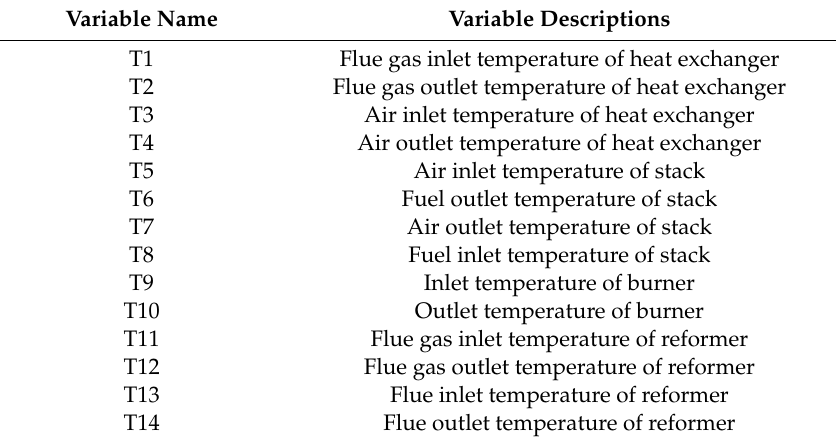
Table 1. Description of related variables of an SOFC system.